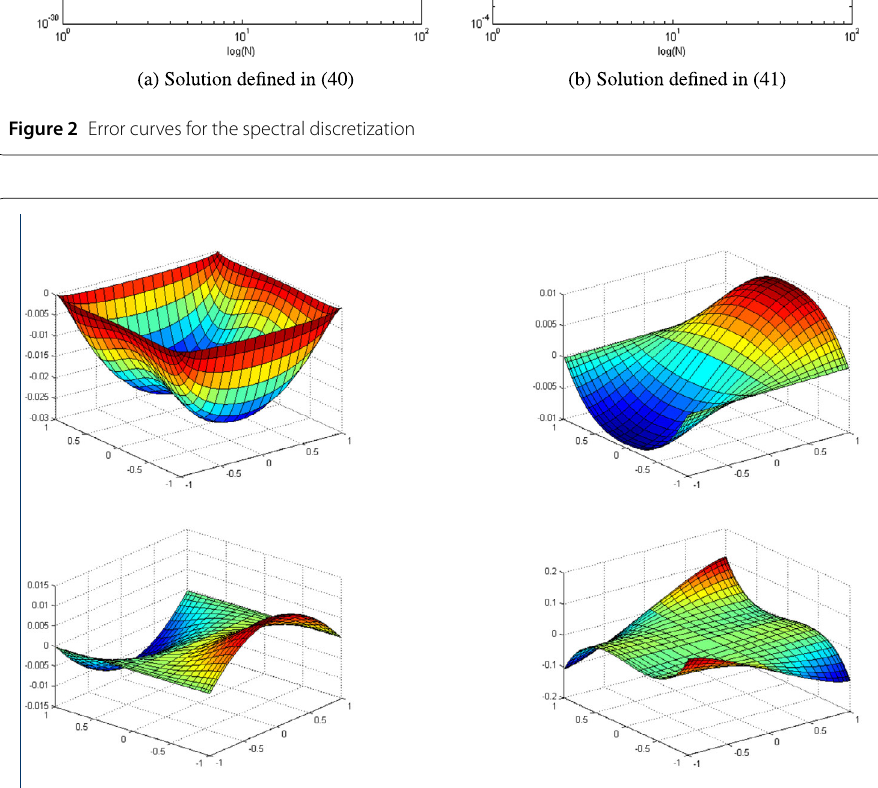
Figure 3 The solution ( τ , u x , u y , p ) for the data f defined in (42) and g =